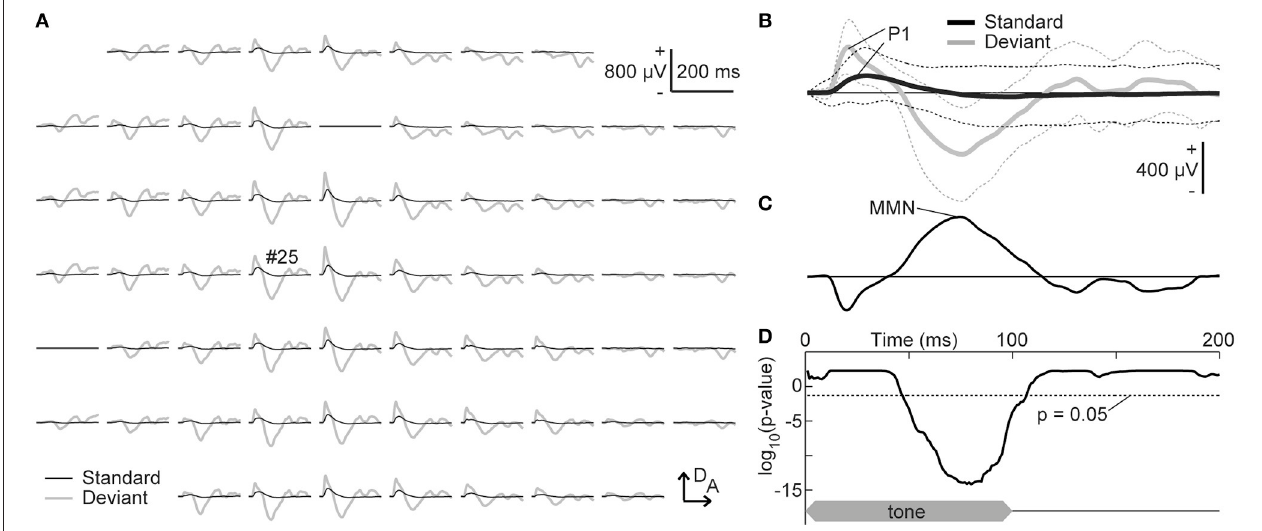
FIGURE 3 | Tone-evoked mismatch negativity (MMN). (A) Representative mapping of grand-averaged standard (black) and deviant (gray) auditory-evoked potentials (AEPs). The frequency of these stimuli was 16kHz, which was paired with 8.0kHz in the oddball paradigm. (B) AEPs from an indicated recording site (#25). The mean (solid lines) ± standard deviation (broken lines) of the 540 (standard) and 60 (deviant) recordings are given. The maximum amplitude of the P1 and MMN in the auditory area was used for the analysis. (C) Difference waves obtained by subtracting the deviant AEPs from the standard AEPs. (D) Significance level under the null hypothesis that deviant AEPs are larger than standard AEPs at a given post-stimulus latency time (one-sided Wilcoxon rank sum test with Bonferroni correction for 200 comparisons). The time course of stimulus presentation is indicated at the bottom of the inset. A, anterior; D,